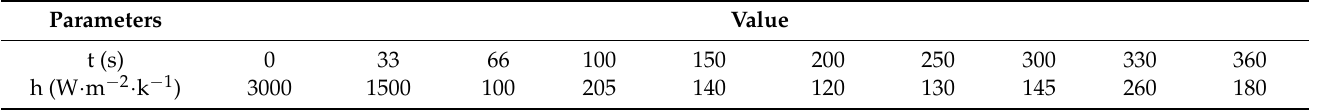
Table 3. Heat transfer coefficient in the